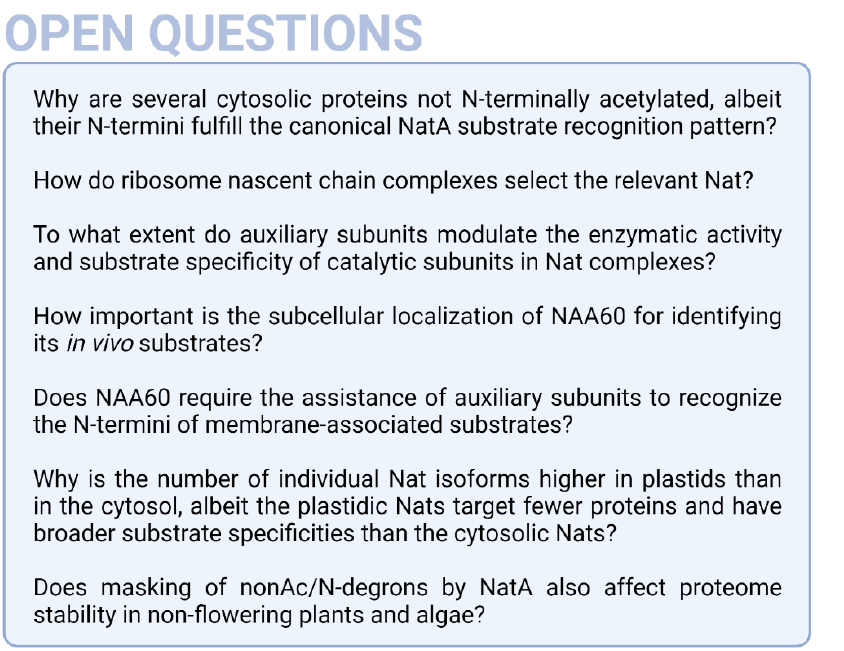
Figure 7. A selection of questions aiming to understand the biological function of Nats in plants.